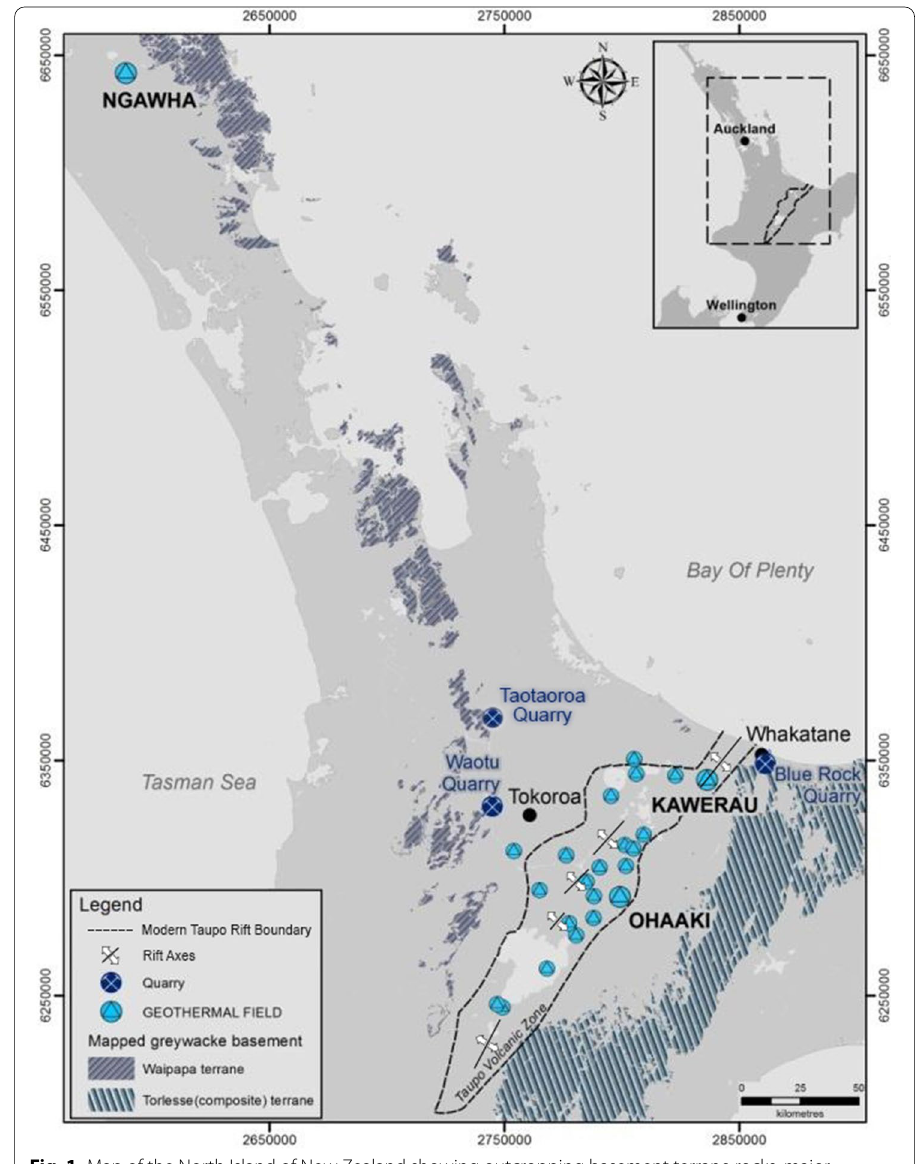
Fig. 1 Map of the North Island of New Zealand showing outcropping basement terrane rocks, major structural components of the TVZ, geothermal field locations, and the locations of the quarries used for sampling for this work. Modified from McNamara et al.